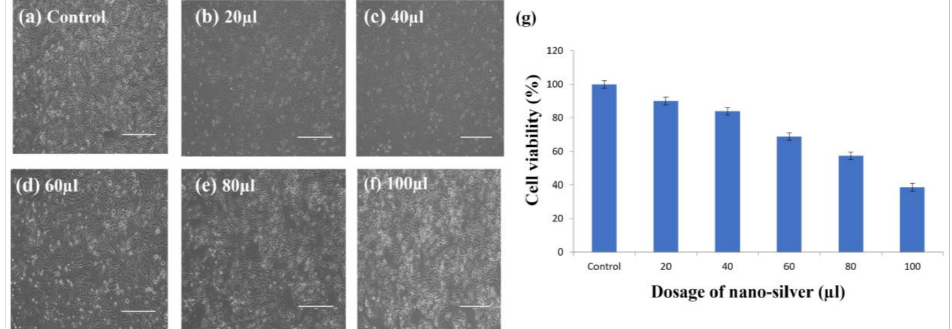
Figure 13. MTT assay of bio-synthesized AgNPs against 3T3 cells ( a ) at different concentrations of AgNPs. a . Control, b . 20 µ L, c . 40 µ L, d .60 µ L, e . 80 µ L, f . 100 µ L proved to decrease the